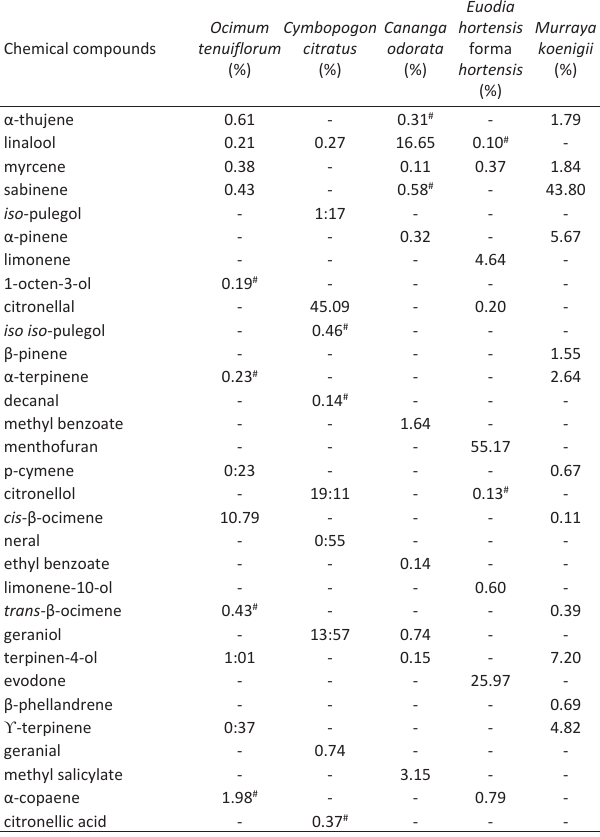
Table 1 - Composition of essential oils (%) from C. odorata (Makasoi), M. koenigi i (Curry leaves), E. hortenis